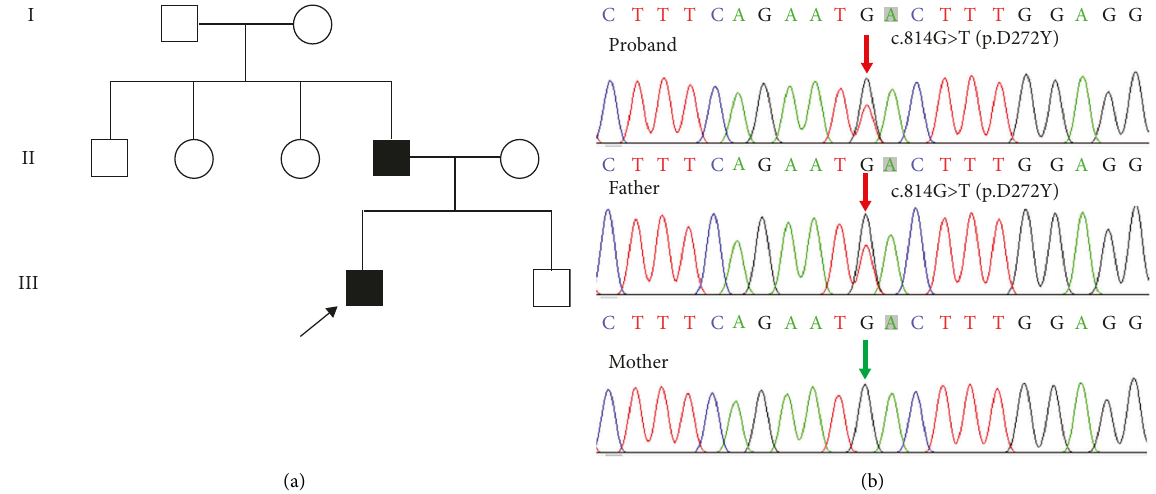
Figure 2: The Chinese family with KS in our study. (a) Pedigree of the family with SEMA3A variant. Squares: males; circles: females; filled symbol: affected; unfilled symbol: unaffected; arrows: proband. (b) Partial DNA sequence diagram of SEMA3A in our case. A novel heterozygous variant (c.814G > T ) in SEMA3A of II-4 and III-1 was identified by WES, causing the substitution of aspartic acid with tyrosine in codon 272, as shown by an arrow.